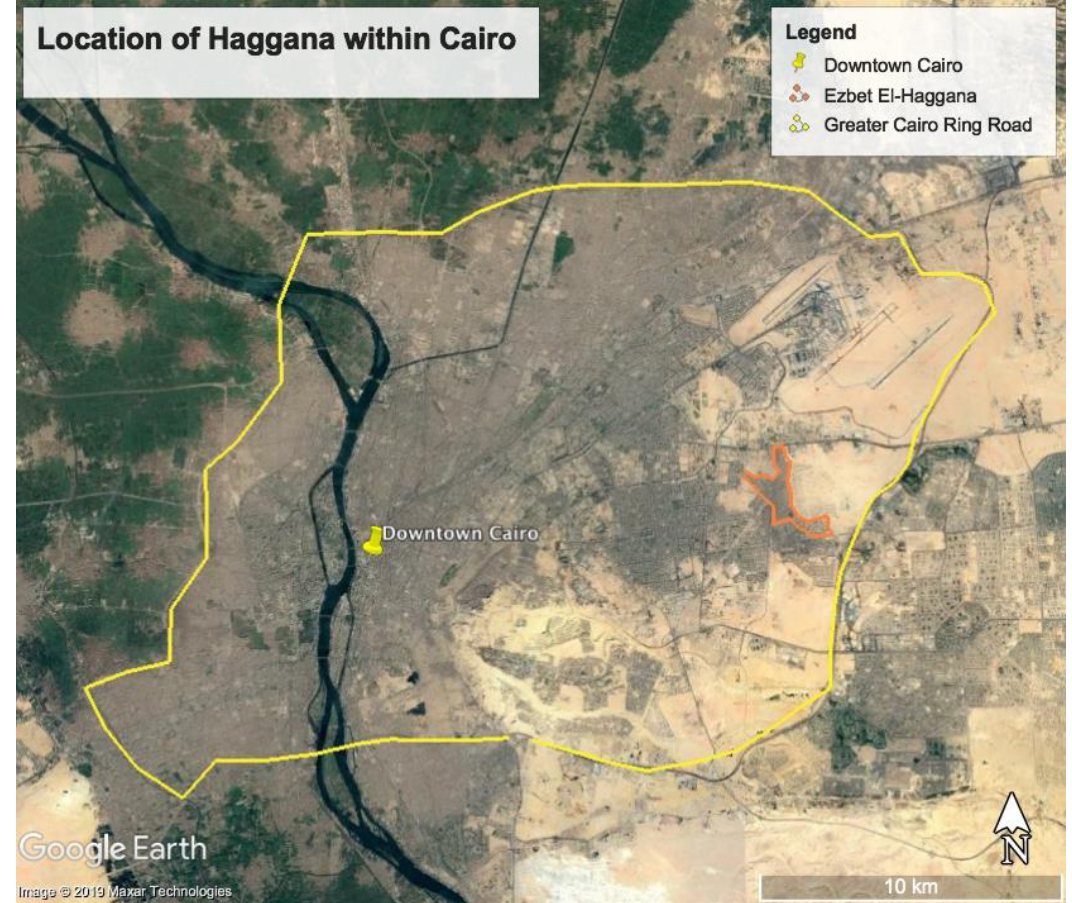
Figure 1. The borders of Cairo, encompassing the borders of East Nasr City, encompassing the borders of Ezbet El-Haggana. Source: Author. of Ezbet El-Haggana. Source: